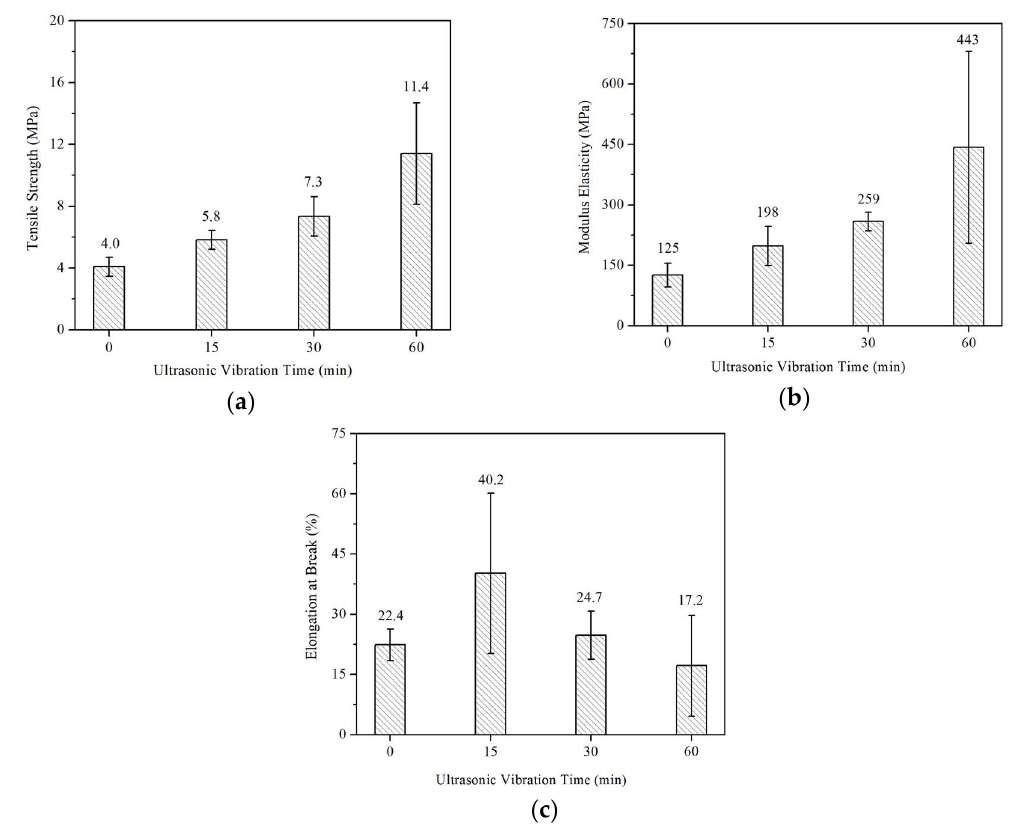
Figure 3. Effect ultrasonic vibration time (UVT) on: ( a ) Tensile Strength (TS); ( b ) Modulus Elasticity (ME); and ( c ) Elongation of break (EB) of bionanocomposite samples.